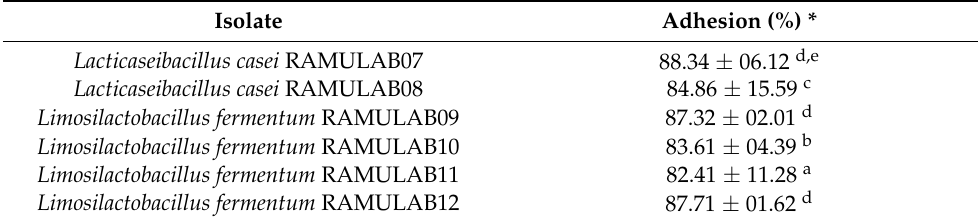
Table 4. Adhesion expressed in percentage of the isolates adhering to HT-29